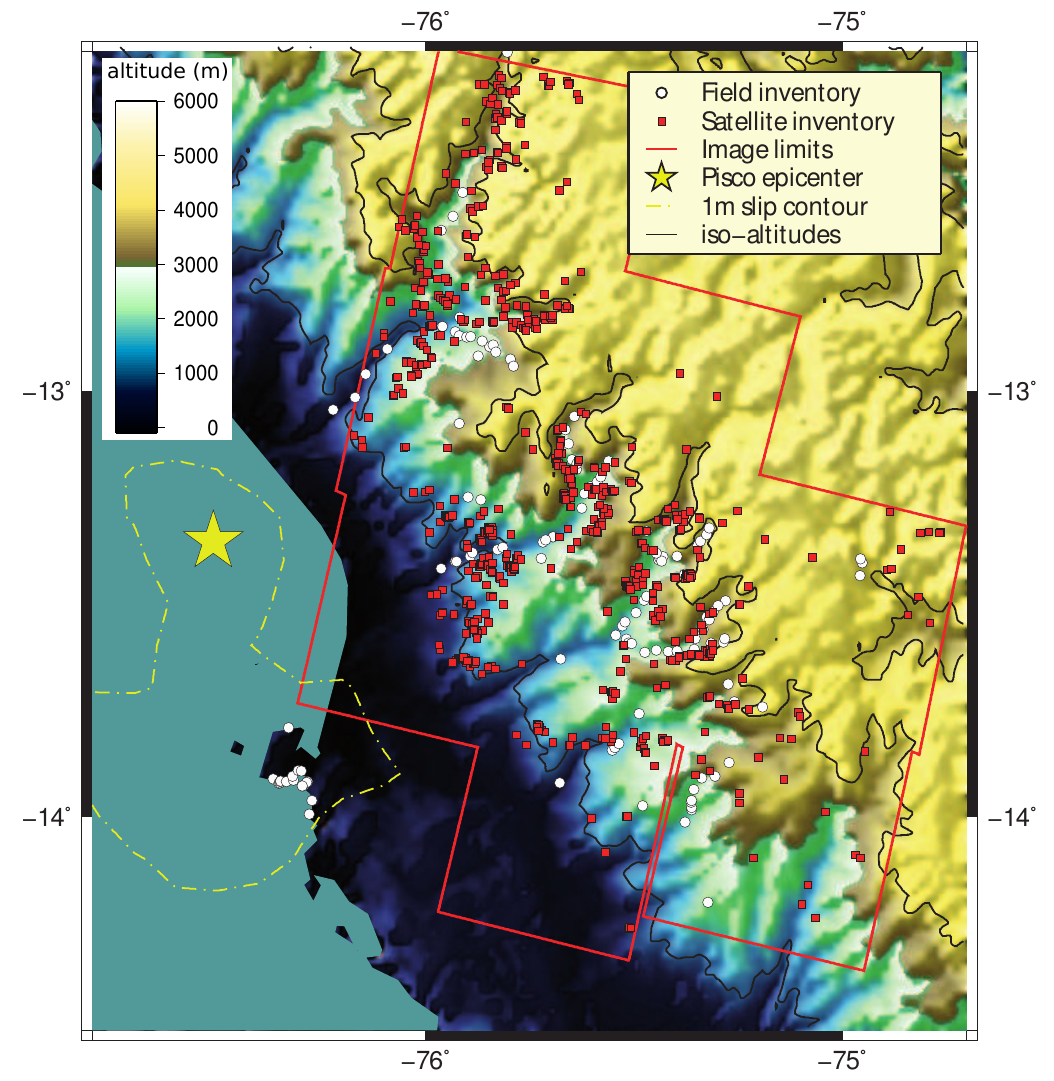
Figure 10. Field (white circle) and remotely-sensed (red square) landslide inventories. The 1 m contour of slip distribution on the fault during the Pisco earthquake is shown with dashed dot yellow line. The red contour is the coverage of the SPOT5 images. Iso-altitudes are lined in black at 1,000 m and 4,000 m